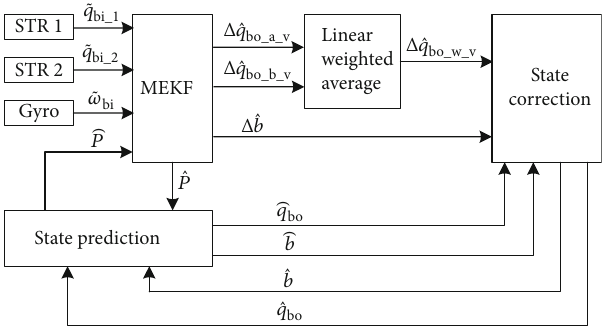
Figure 7: The centralized layout